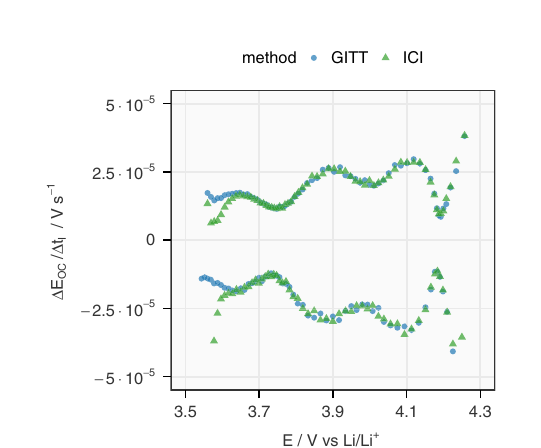
Fig. 3 | Comparison between the diffusion resistance coef fi cient derived from Fig. 5 | Comparison between the Li-ion diffusion coef fi cient derived from the theGITT,ICImethodandEIS. Thediffusionresistancecoef fi cient( k )inNMC811in GITT and ICI method. The Li-ion diffusion coef fi cient in NMC811 ( D ) in Cell 1 at Cell1duringcharginganddischargingareplottedagainsttheOCPoftheelectrode various OCP of the electrode( E )derived from the GITTwithdataselectioninterval ( E ) in a , b , respectively. The GITT data were fi tted with data selection interval 5 – 40s and the ICI method during charging and discharging are plotted in a , b , respectively. The minimum of the y -axis is set to 10 − 13 cm 2 s − 1 to show the 5 – 40s. The EIS results are derived from the linear relationship between k and the ffiffiffiffiffiffiffiffiffi p coef fi cient of the Warburg element ( σ , k= σ 8 = π ). The maximum of the y -axis is differences of the data above 3.7V. The analysis of the difference between the set to 30 Ω s − 0.5 to show the differences of the data above 3.7V. Due to a technical values derived from the GITT and ICI methods can be found in Supplementary issue, the spectrabelow3.8V in the fi rst chargewere not properly collected, but it Fig. 5. The error bars originate from the errors in k, as shown in Fig. 3, which stem from the standard deviation of linear was solved afterwards. The analysis of the difference between the values derived from the GITT and ICI methods can be found in Supplementary Fig. 11. The error bars originate from the standard deviation of linear regression.